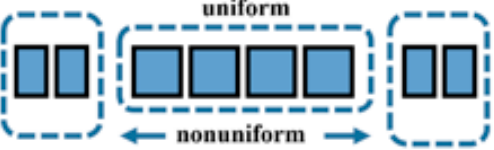
Figure 5. Regional distribution of an MNULA.